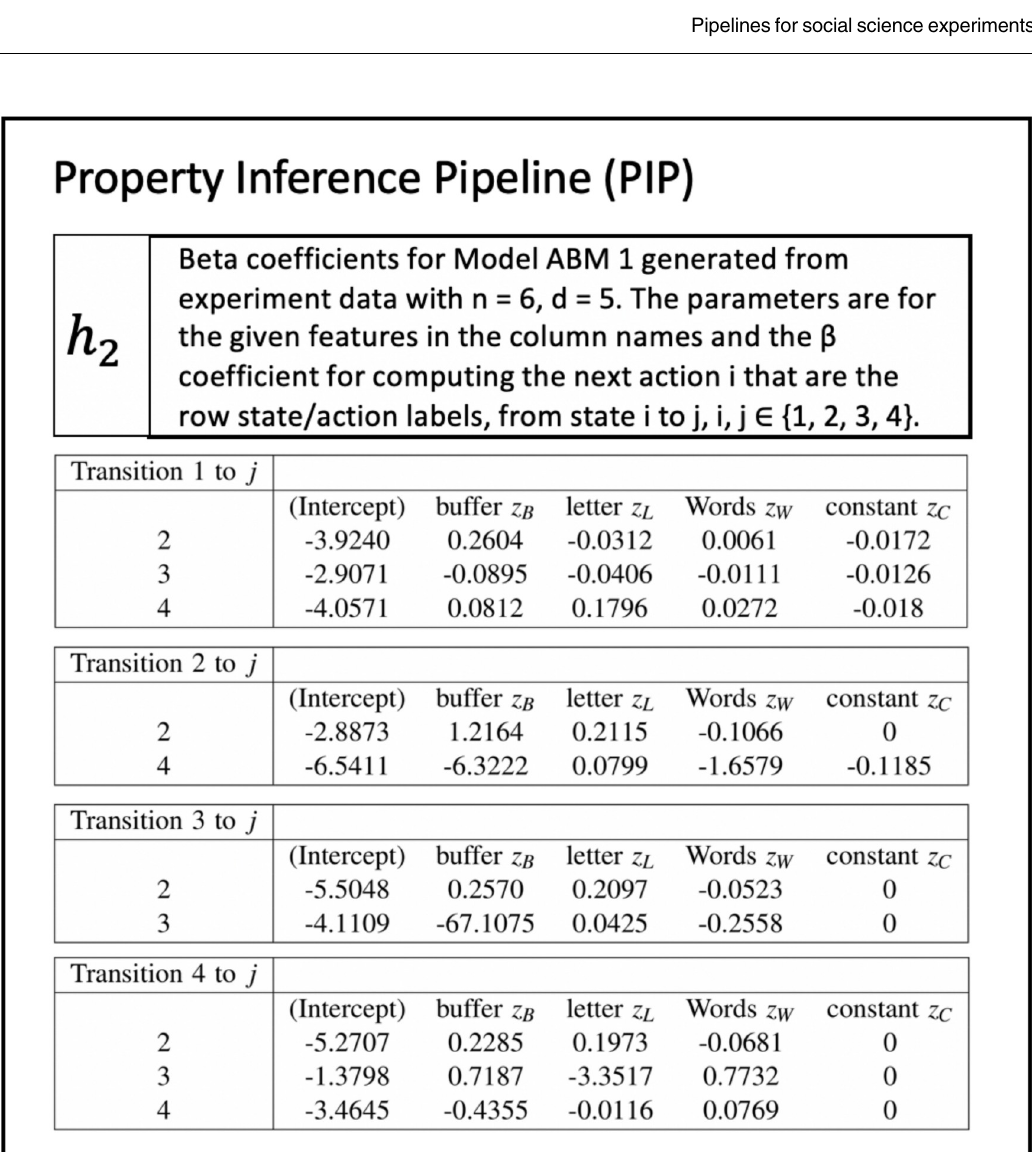
implement a web-based public goods experiment, and to recruit participants around the world. In [63], a repeated public goods experiment was implemented in the free web-based platform for interactive online experiments, LIONESS [36], and participants were recruited via Amazon Mechanical Turk (MTurk). In [37] a modular virtual lab named Empirica offers a development platform for virtual lab experiments, and they claim that is even accessible to novice programmers. There are tools that focus in Adaptive Experimentation, like Facebook Ax [38], an accessible, general-purpose platform for understanding, managing, deploying, and automating adaptive experiments. Usually these platforms only focus on the design and run- ning of online lab experiments, but they don’t offer a complete automated solution for experi- ments, analysis, modeling and simulation, and evaluation.